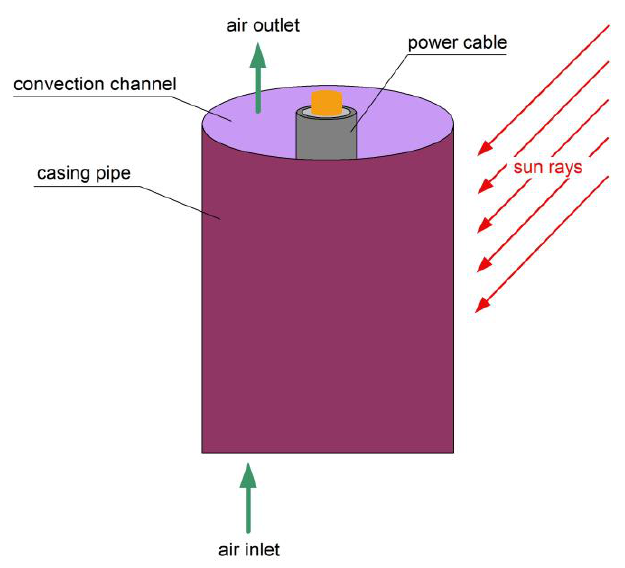
Figure 11. Arrangement of the power cable inside the pipe.